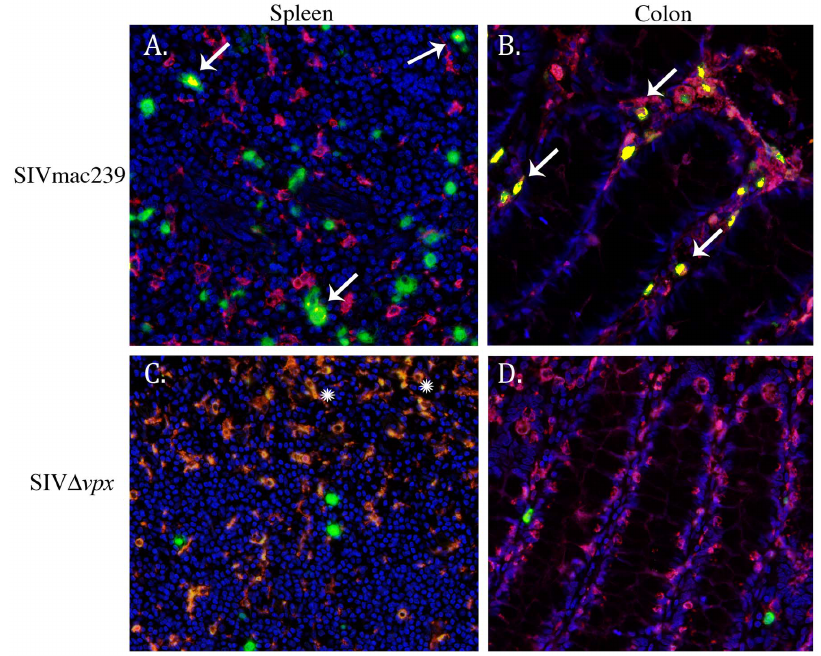
Figure 6. Spectral imaging and colocalization of double-label immunohistochemistry slides of spleen and colon. Immunofluorescence with SIV nucleic acid (green), Ham56 + macrophages (red), and coexpression (yellow, arrows) demonstrate that infected macrophages are readily evident in SIVmac239-infected monkeys ( A, B, arrows ), particularly within the colon ( B ), but are absent in spleen and colon from SIV D vpx -infected monkeys ( C, D ). Snowflake symbols in C denote autofluorescence in red pulp macrophages. Original magnification 40 6 ( A – D ).